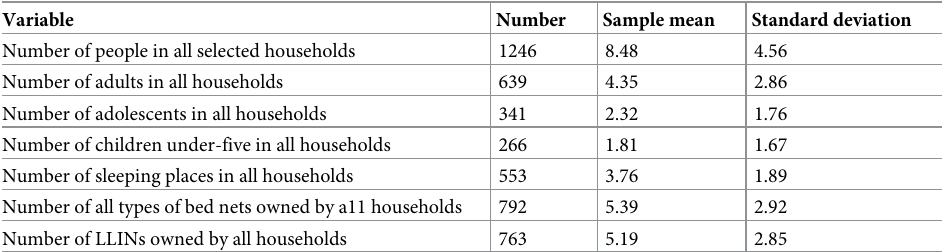
Table 1. Descriptive statistics of the demographics of study households (n = 147).